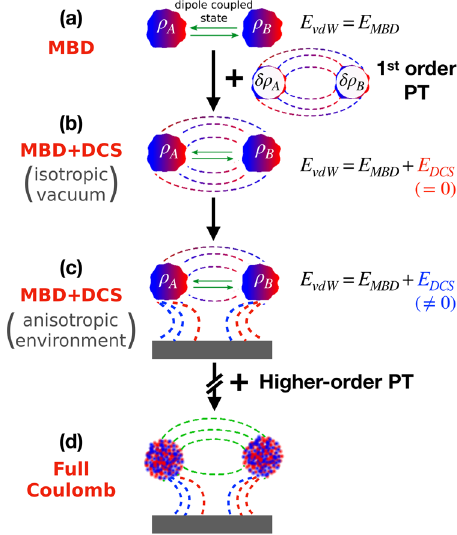
Fig. 1 Schematic representation of dipole-correlated Coulomb singles (DCS). a Green arrows represent dipole coupling between electronic fragments. First-order perturbation theory (PT) on top of the many-body dispersion formalism (MBD) captures the interaction energy, E DCS , between δρ δρ fi eld lines. b E A and B , depicted by DCS vanishes in 3D isotropic vacuum because of symmetry. c Under rotational symmetry-breaking con fi nement, electric fi eld lines between electronic fragments deform, which leads to E ≠ 0. d Further inclusion of higher-order terms leads to full Coulomb- DCS coupled vdW